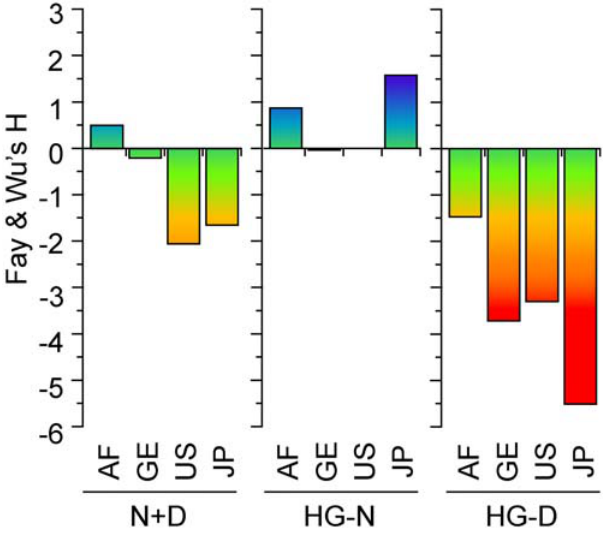
Figure 3. Fay and Wu’s Hvalues for both HG-N and HG-D haplotypes are plotted for AF, GE, US and JP in thermal scale. Similar plots for Tajima’s D and Fu and Li’s D are presented in Figure S4.